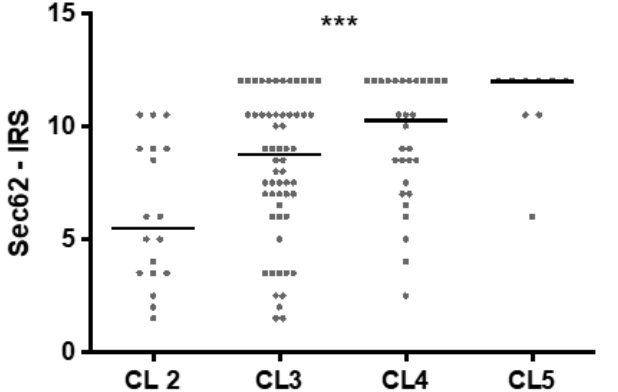
Figure 4. Correlation of SEC62 expression with Clark levels (CL) in melanomas (MM + MET). Sec62-IRS delineated for Clark Levels 2 ( n = 19) vs. 3 ( n = 58) vs. 4 ( n = 30) vs. 5 ( n = 10). Every dot represents one patient and the median is indicated by a line. Statistics: one-way ANOVA test. ***— p < 0.001.